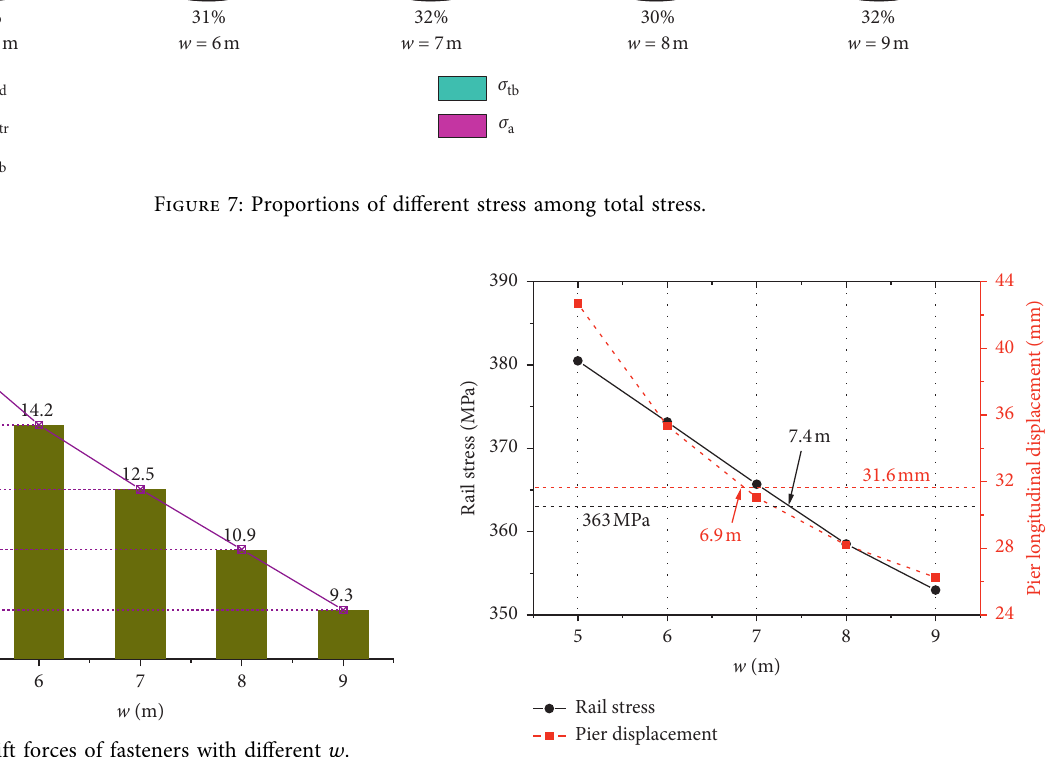
Figure 10: Suggested w for the designed